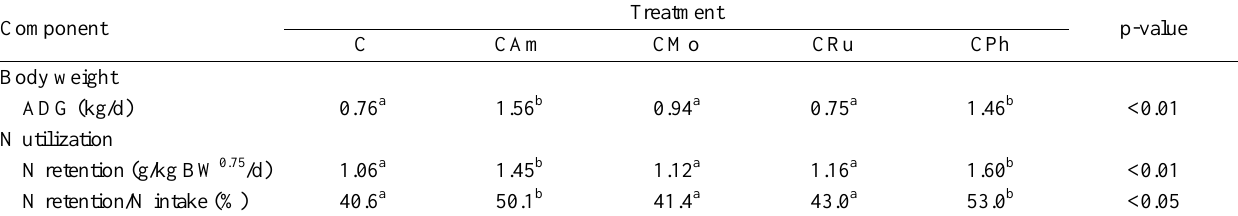
ADG, average daily gain; BW, body weight; N, nitrogen. 1 C, cocoa pod without any treatment; CAm, ammoniated cocoa pod with 1.5% urea; CMo, fermented cocoa pod with 3% molasses; CRu, fermented